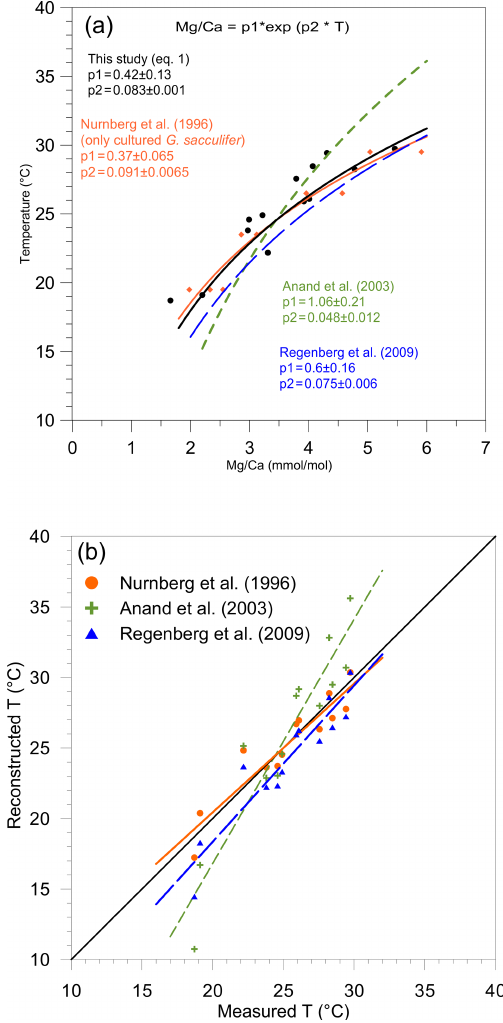
Figure 3. (a) Mg/paleotemperature equations established in this study (Eq. 1) (black dots and full line); based on the data of Nürn- berg et al. (1996) (orange diamonds and large, full orange line), Anand et al. (2003) (small dotted green lines), and Regenberg et al. (2009) (large dotted blue line). (b) Reconstructed Mg tempera- tures (October/November 2005) plotted versus measured tempera- tures ( ◦ C) presented in Table 1. For each station, mean measured Mg / Ca was inserted into the equation of Nürnberg et al. (1996) (only cultured specimens of T. sacculifer ) (orange dots, full line), the equation of Anand et al. (2003) (green crosses, small dashed line), and the equation of Regenberg et al. (2009) (blue triangles, large dashed